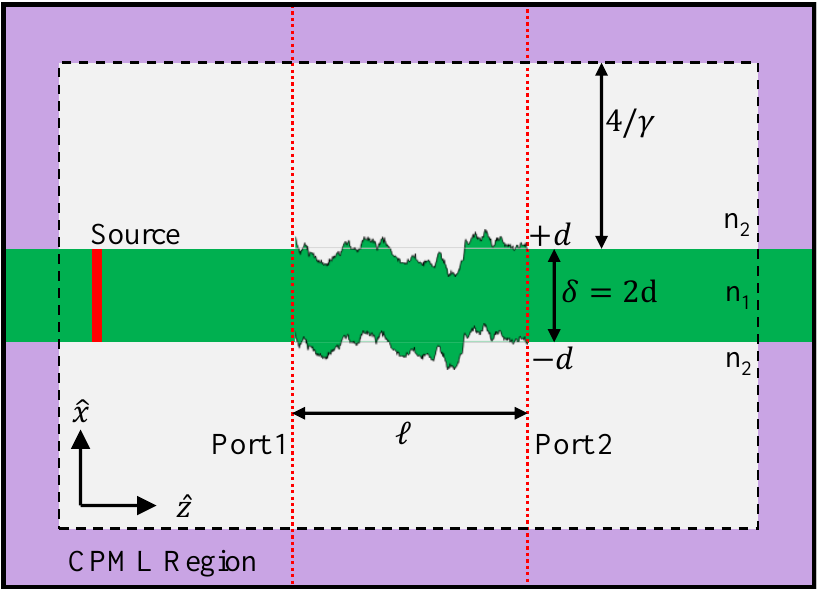
Figure 1. The baseline dielectric slab waveguide